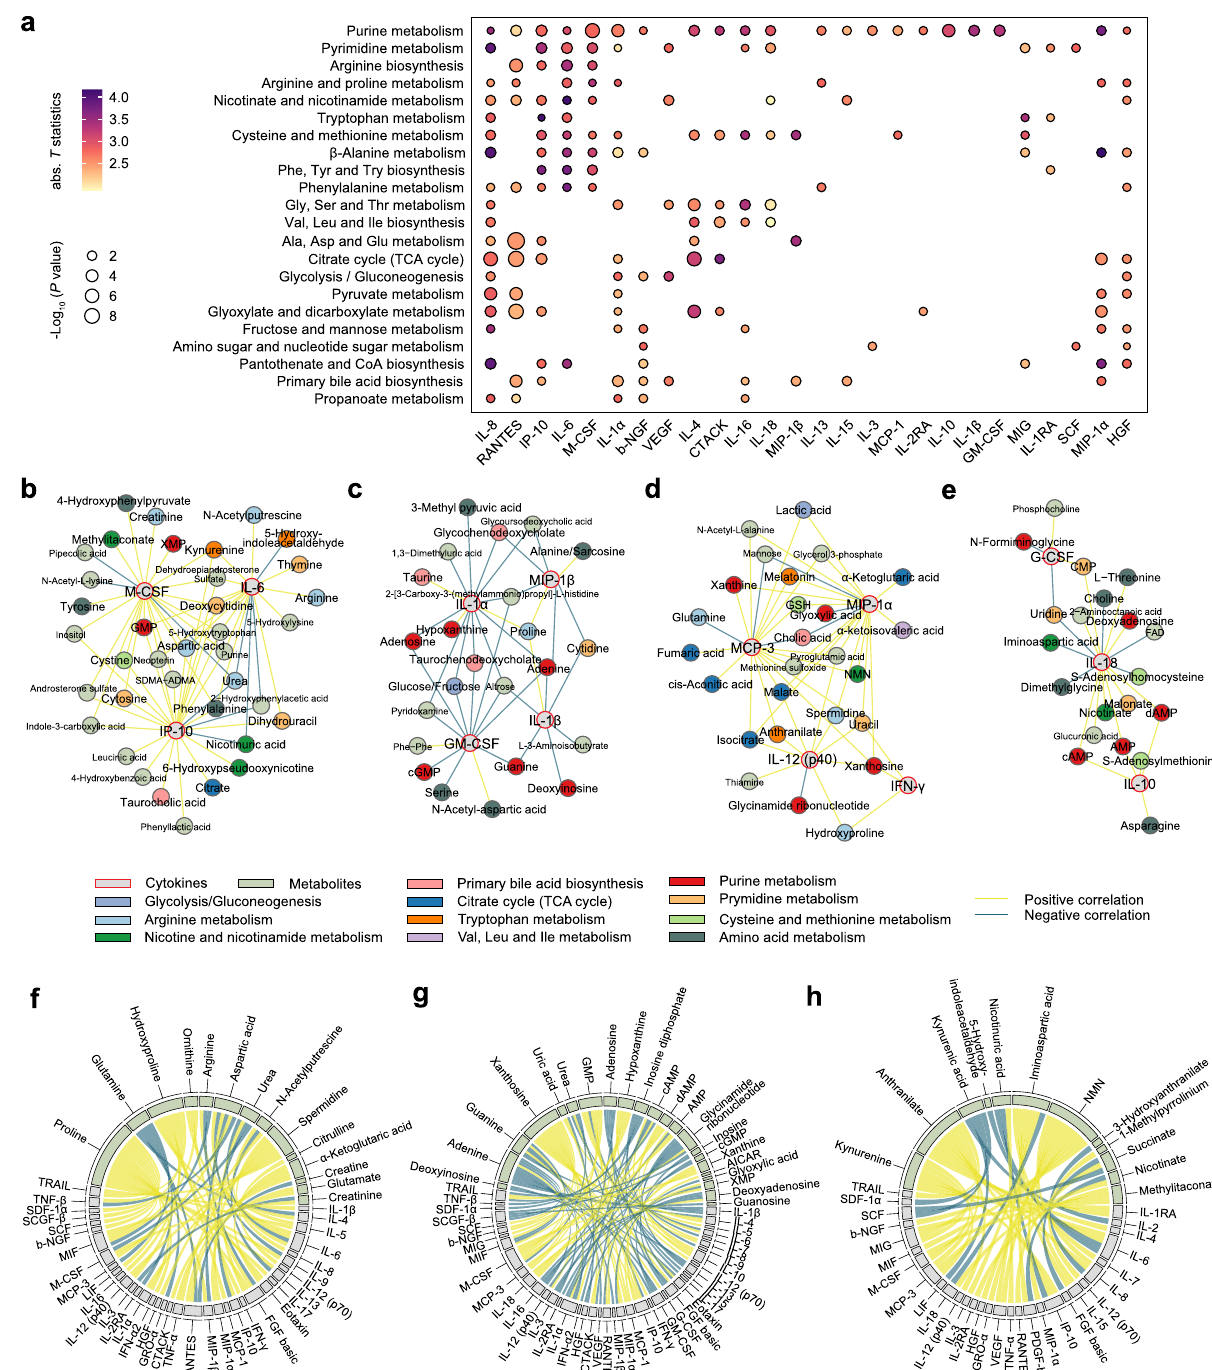
Fig. 2 Metabolite – cytokine correlation in serum samples from COVID-19 patients. a Pathway enrichment analysis of metabolites signi fi cantly associated with the indicated cytokines in severe patients ( n = 23). Two-sided t test followed by Benjamini-Hochberg (BH) multiple comparison test with FDR < 0.1. “ abs. T statistics ” is the mean absolute T statistics of signi fi cant metabolites in the pathway and is represented by color intensity. The dot size represents pathway signi fi cance (one-sided Fisher ’ s exact test followed by BH multiple comparison test). b – e Correlation networks of key CRS-related cytokines and metabolites in severe patients. Nodes and edges are color-coded by molecule types and metabolic pathways, and association directions, respectively. Networks were clustered by fast greedy modularity optimization algorithm. f – h Chord diagrams depicting the signi fi cant correlations of cytokines with metabolites involved in arginine metabolism ( f ), purine metabolism ( g ), tryptophan and NAD + metabolism ( h ), respectively, in severe patients. Chords are color-coded by association directions consistent with ( b – e ).